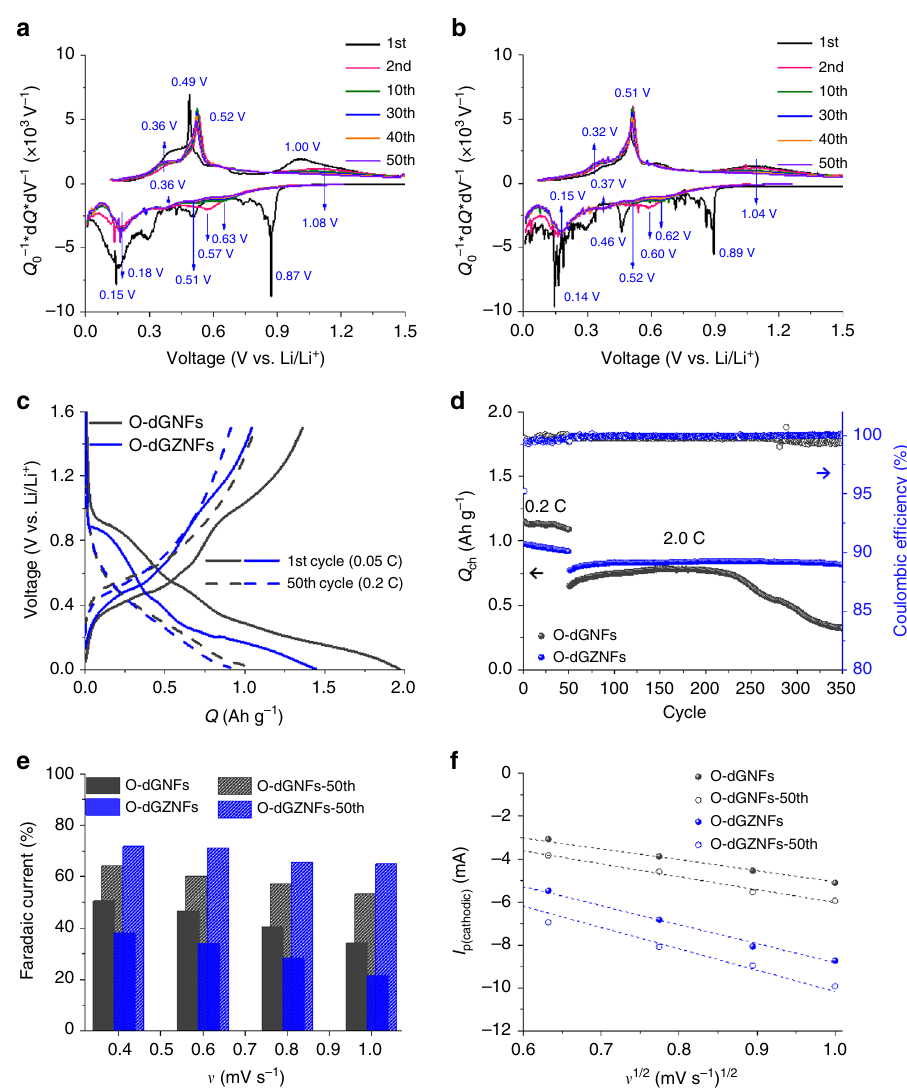
Fig. 3 Electrochemical properties of O-dGNF and O-dGZNF electrodes. Differential capacities of a O-dGNFs and b O-dGZNFs for featured cycles. c Discharge/charge pro fi les at the 1st cycle (bold line) and 50th cycle (dashed line). d Charging capacity retention at 0.2 and 2.0 C-rate. e Comparison of the faradaic current of pristine and 50-cycled electrodes at various scan rates. f Plots of squared scan rate vs. peak current calculated by the Randles – Sevcik equation